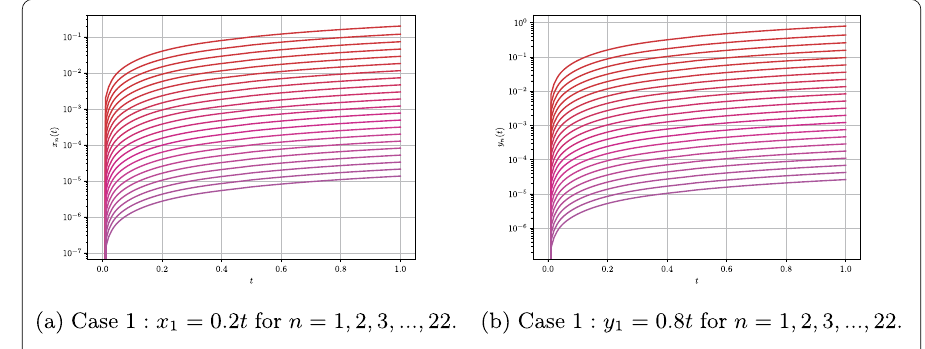
Figure 3 The convergence behavior of { x n ( t ) } and { y n ( t ) } with x 1 = 0.2 t and y 1 = 0.8 t (Case 1) in Example 5.2, the y -axis is illustrated on a logscale